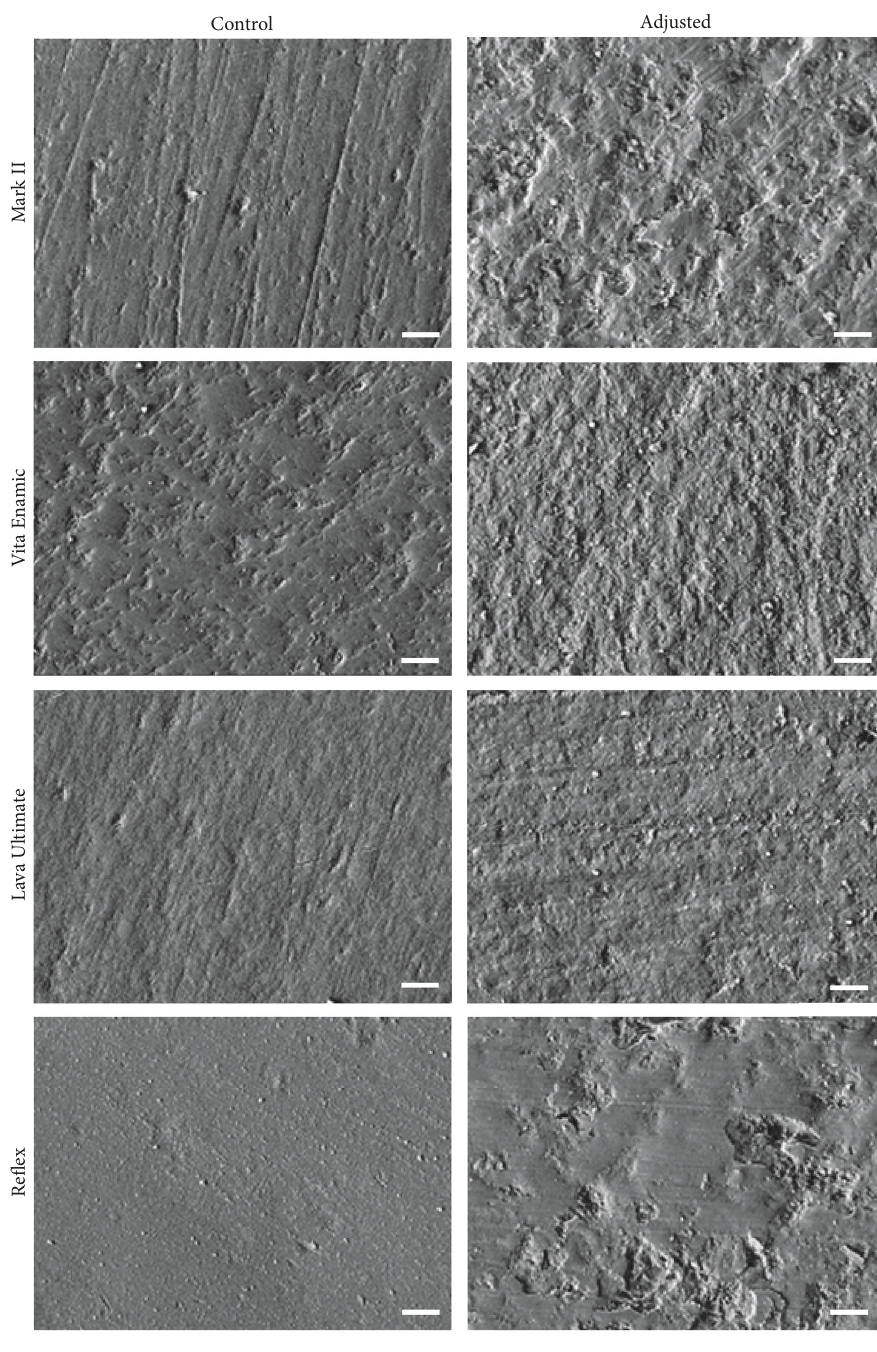
Figure 1: SEM images (magnification 1000x) of control and adjusted surfaces of ceramic materials (scale bar = 10 𝜇